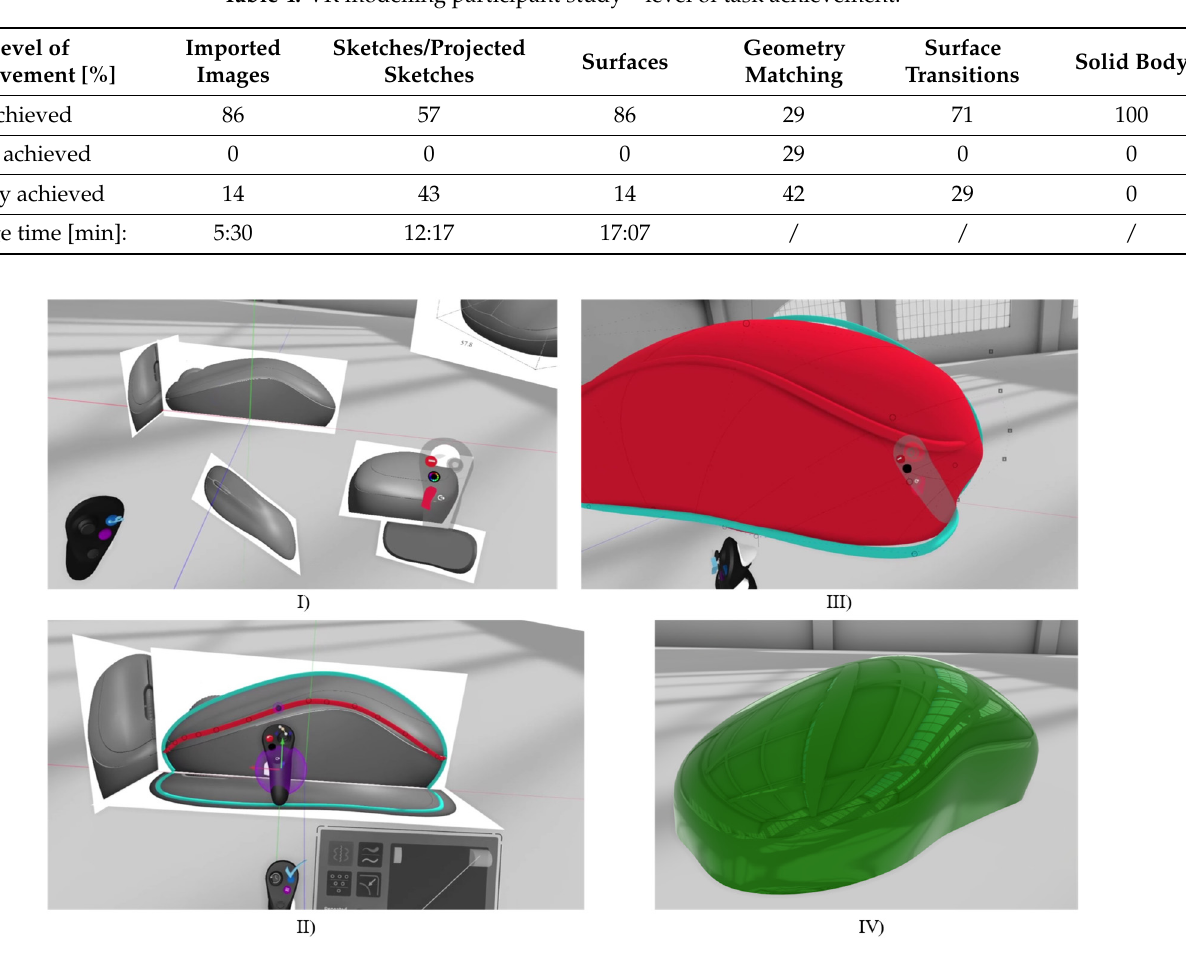
Figure 9. Phases in VR part modelling. ( I ) Image placement; ( II ) Sketching the rough outline; ( III ) Surface creation; ( IV ) Final model. ( IV ) Final